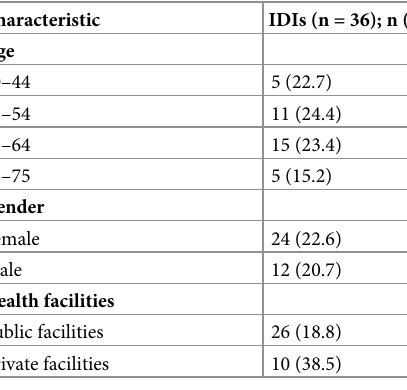
Table 2. Patient participant